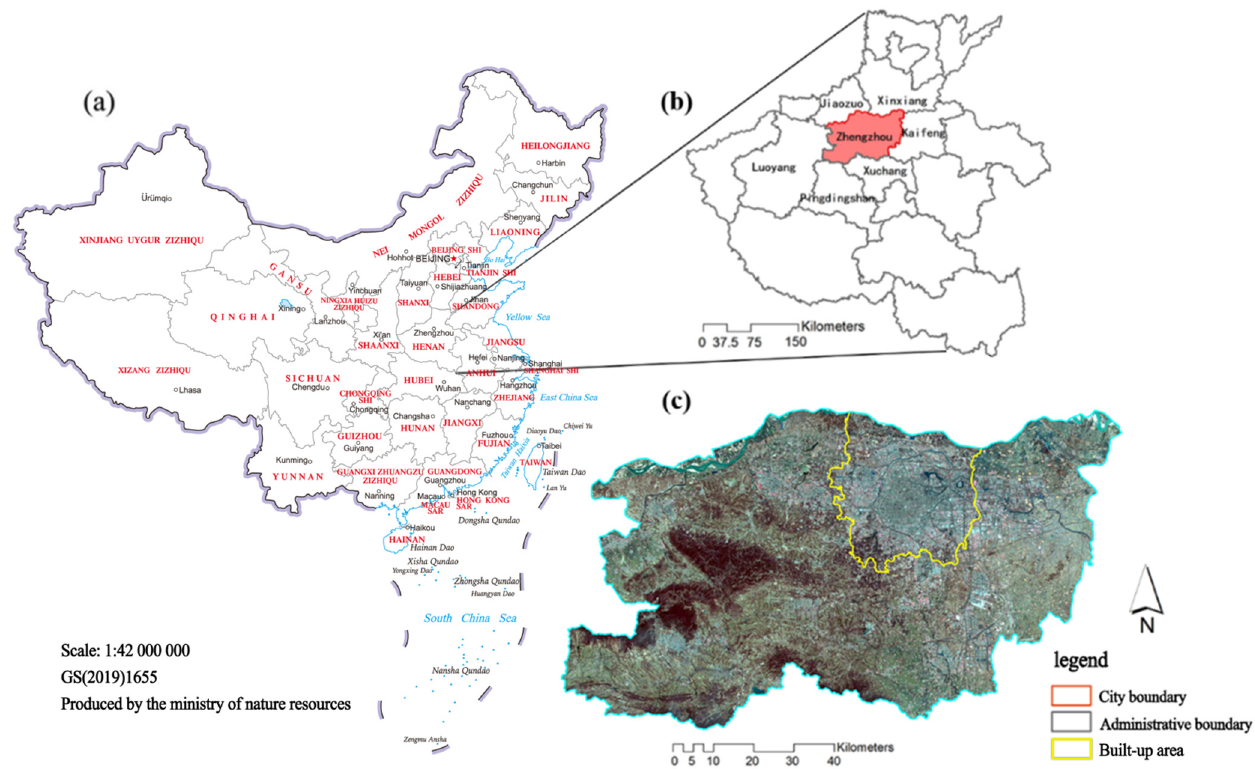
Figure 1. ( a ) Location of Zhengzhou, Henan Province, in China; gray lines indicate the boundaries of provinces and terri- tories. ( b ) Henan province; black lines depict city boundaries. ( c ) Satellite image of Zhengzhou; the area within the yellow polygon is the built-up area of Zhengzhou.